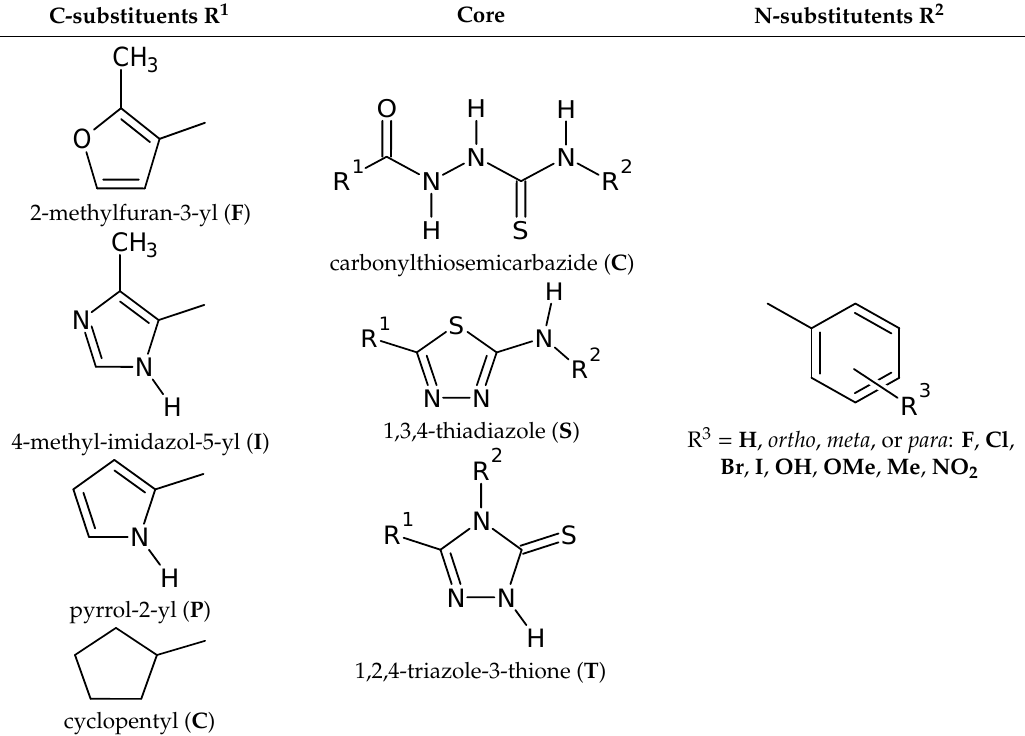
Figure 1. Chemical structure of the compound FSoOH . Table 1. Lists of structural fragments of the compounds used in the current study.